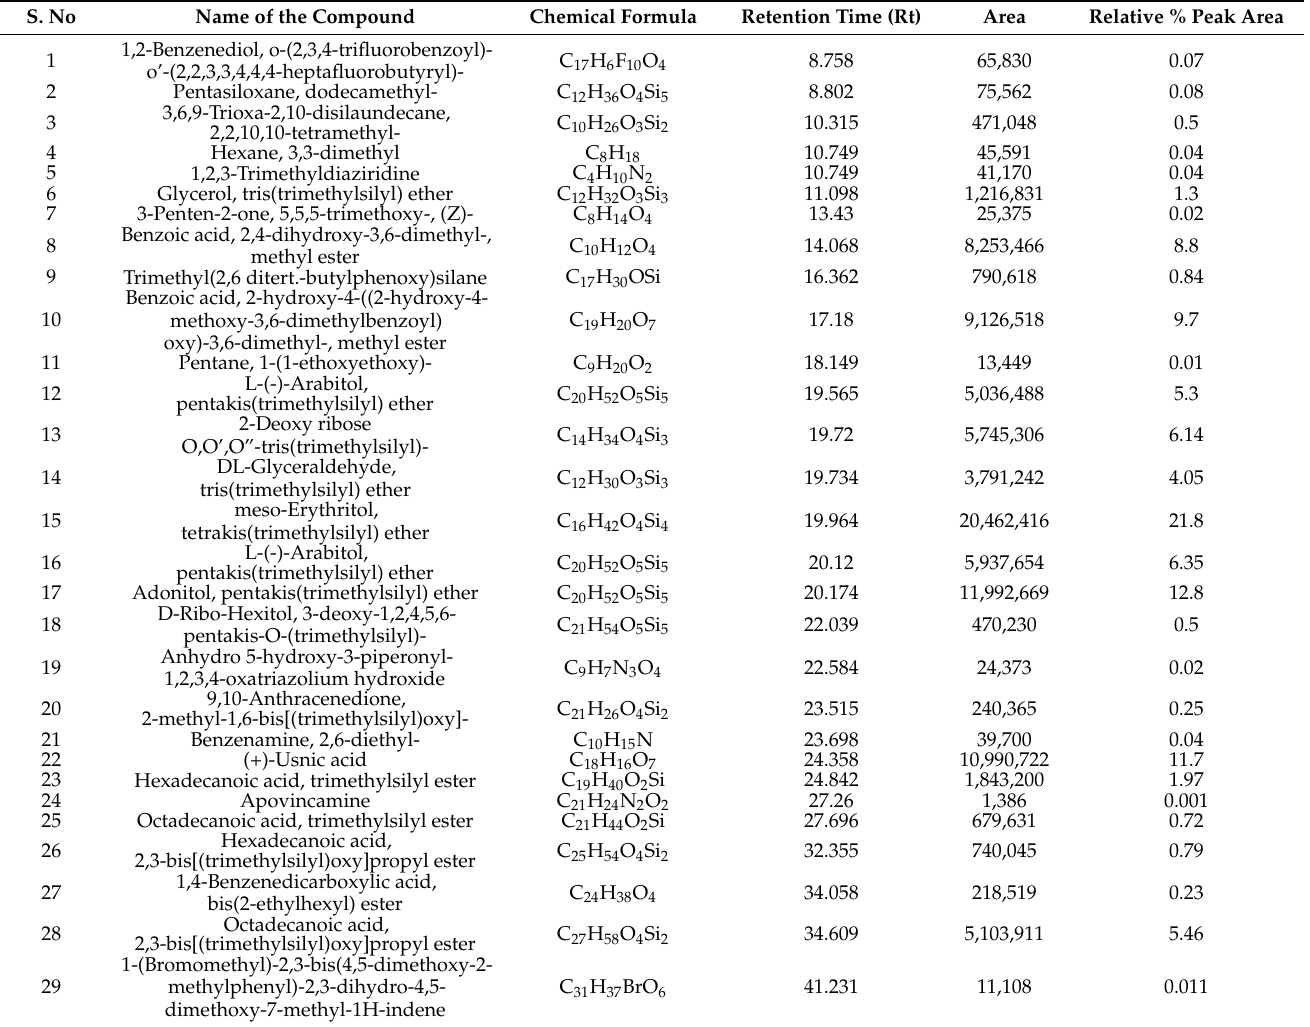
Table 3. GCMS analysis of Usnea cornuta acetone extract (UC2A) for detection of lichen